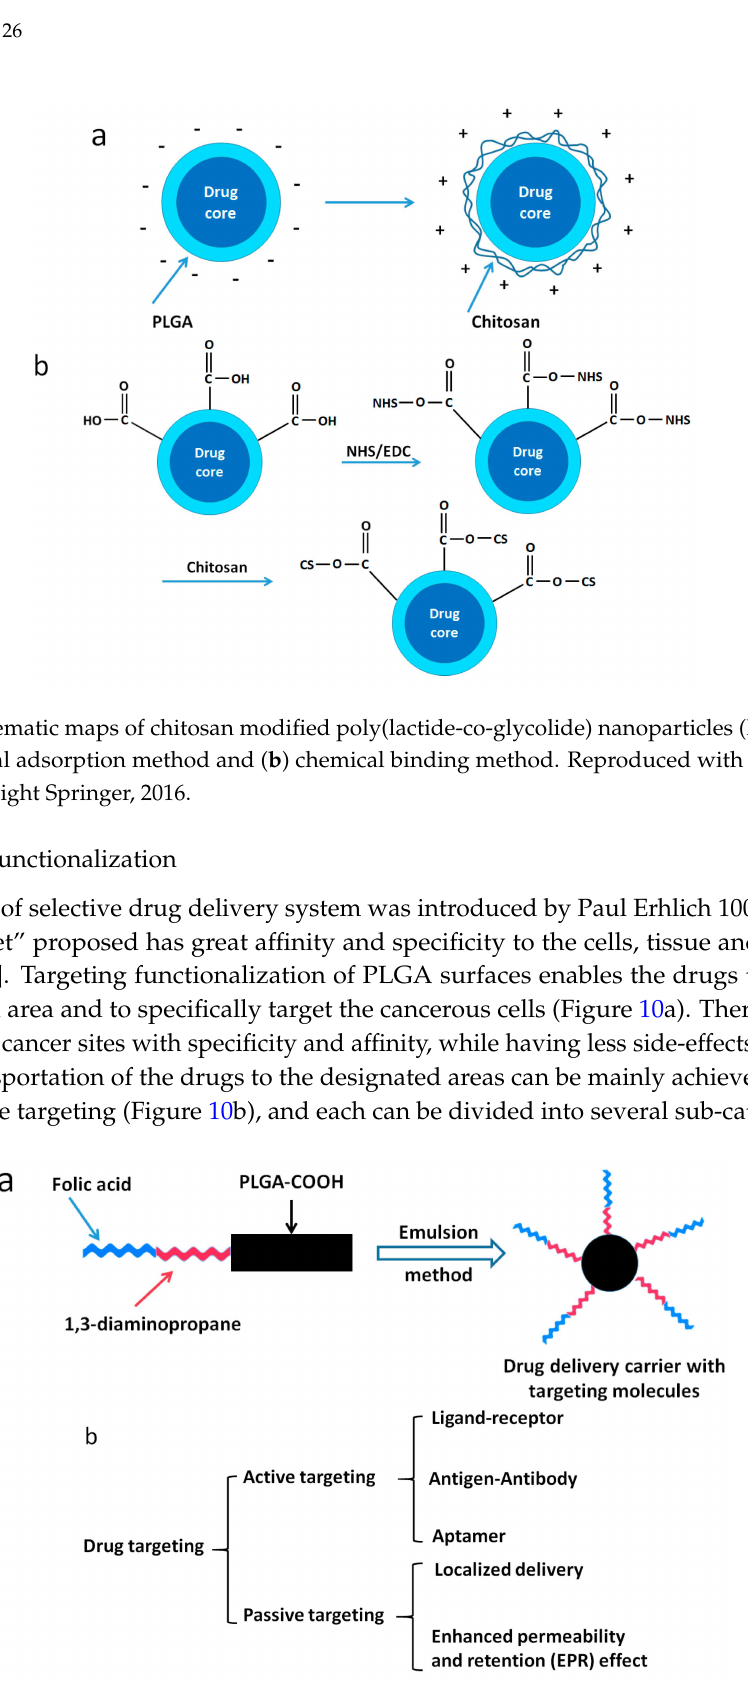
Figure 10. ( a ) Formation of the PLGA-1, 3-diaminopropane-folic acid targeting drug delivery system. ( b ) Classification of targeting drug delivery